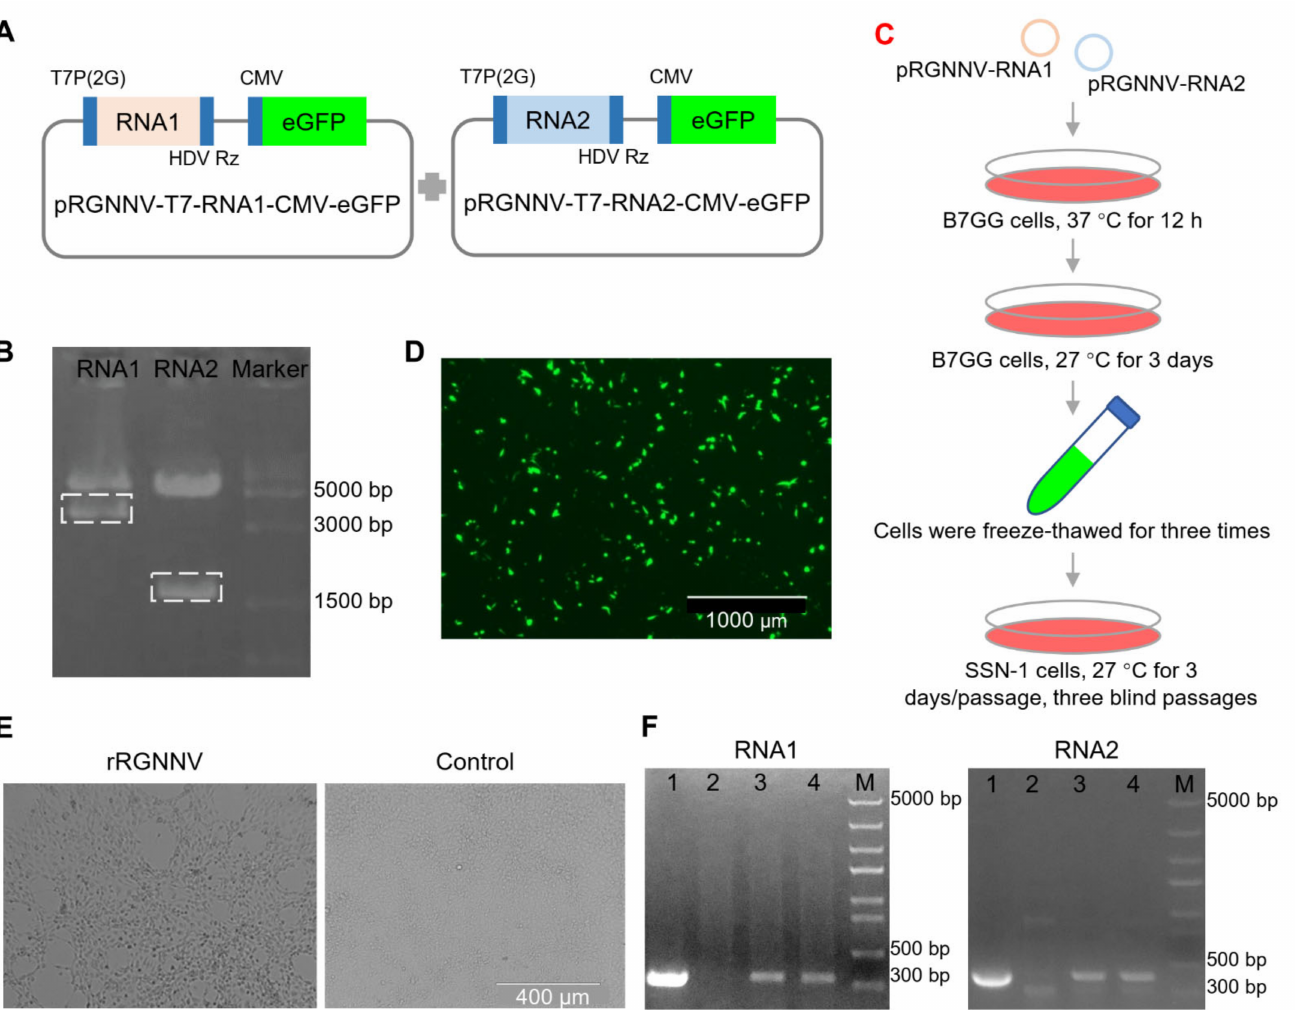
Figure 1. Construction and generation of rRGNNV. ( A ) Schematic representation of the construction for pRGNNV-T7-RNA1-CMV-eGFP and pRGNNV-T7-RNA2-CMV-eGFP encoding the full-length RNA1 and RNA2 of RGNNV, respectively. ( B ) Confirmation of the constructed plasmid pRGNNV- T7-RNA1-CMV-eGFP and pRGNNV-T7-RNA2-CMV-eGFP by restriction digestion with enzyme Bgl II and Eco R I. The predicted products were about 3100 and 1400bp, respectively. ( C ) Flow chart of rRGNNV virus rescue. ( D ) Rescuing rRGNNV in B7GG cells. B7GG cells were transfected with plasmids pRGNNV-T7-RNA1-CMV-eGFP and pRGNNV-T7-RNA2-CMV-eGFP, then cultured for 3 days. ( E ) Replication of rRGNNV and its cytopathic effect in SSN-1 cells. The supernatants collected from ( D ) were incubated with fresh SSN-1 cells and the CPE was observed daily. ( F ) Confirmation of rRGNNV infection in SSN-1 cells by RNA1 and RNA2 RT-PCR. RGNNV RNA1 ( left ) and RNA2 ( right ) were detected by RT-PCR for the cells collected from ( E ), lane 1: SSN-1 cells with wtRGNNV infection were used as positive control; lane 2: sample from the right panel of ( E ) was used as negative control; lane 3 and 4: sample form the left panel of ( E ); M: DNA